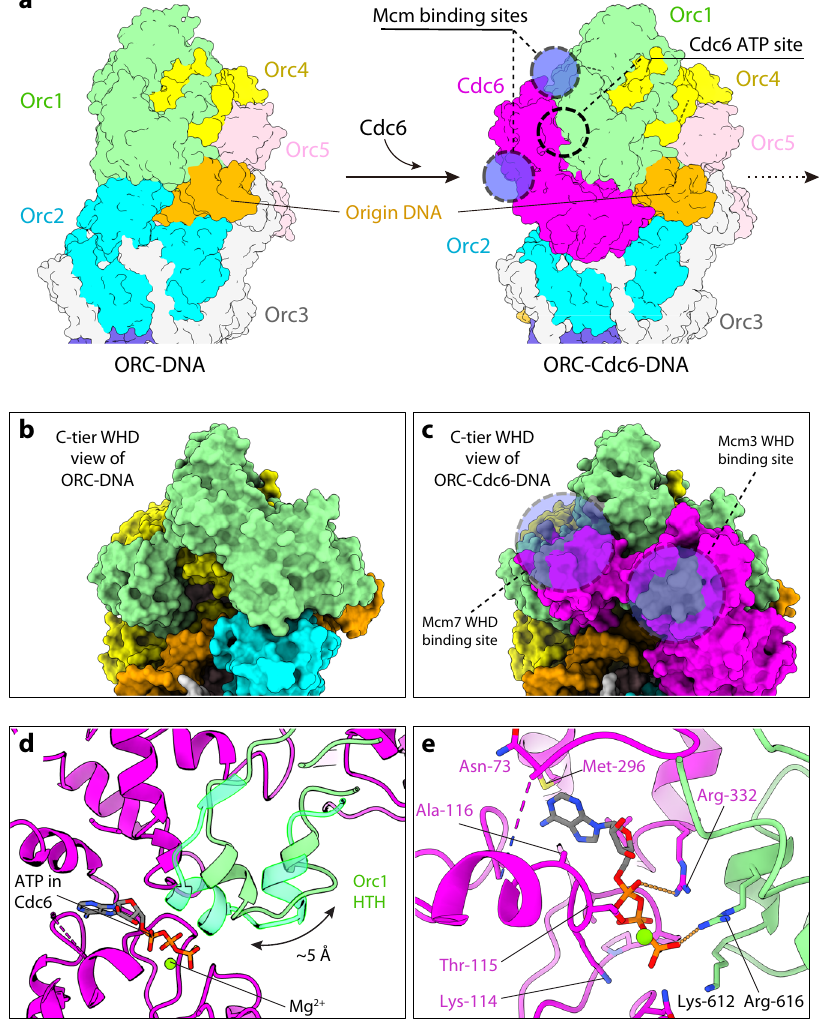
Fig. 5 Structural change in Orc1 that accommodates Cdc6 binding and activates the Cdc6 ATPase. a Comparison of ORC (left) and ORC – Cdc6 (right) in surface view showing that the binding of the Cdc6 to ORC leads to the assembly of three composite Mcm2-7 binding sites, which are absent in ORC itself. b , c Enlarged view of panel a showing the absence ( b ) and the presence ( c ) of the binding sites (dashed black circles) for the WHDs of Mcm3 and Mcm7. d A short α -helix of Orc1 AAA + domain shifts by 5Å upon Cdc6 binding to form the ATP-binding pocket of Cdc6. e The Cdc6 ATP binding site is formed by side chains from both Cdc6 and Orc1. Orc1 Arg-616 serves as the arginine fi nger for the ATP in Cdc6. ATP γ S and surrounding residues are shown as